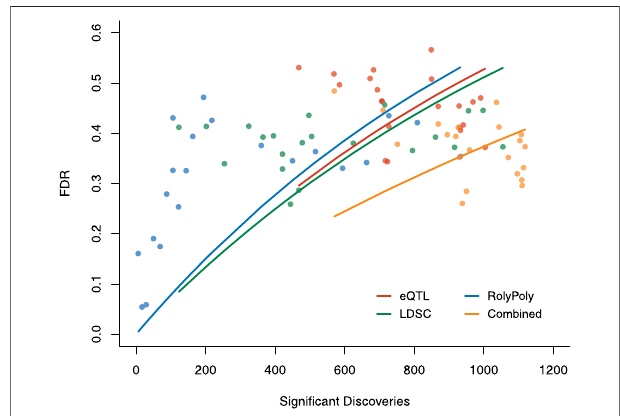
FIGURE 4 | The overall performance of three methods and the combined results in terms of FDR v.s. the number of claimed signi fi cant discoveries. We calculated the FDR for each method and the overall FDR for the combined result based on the estimated operating characteristics. Eachpointwasevaluatedunderaparticular p -valuethreshold:0.01,0.02, ... , 0.09, 0.1, 0.2, ... , 0.9. Each curve was fi tted for the exponential model of Y